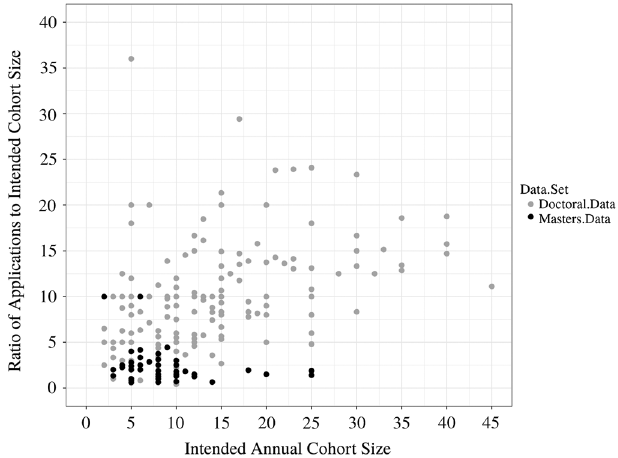
FIG. 1. Application pressure (ratio of application received to intended cohort size) versus the size of the